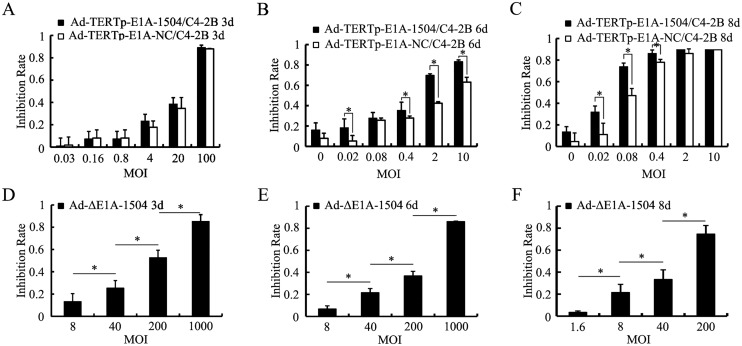
Inhibition effects of Ad-TERTp-E1A-1504 on C4-2B cells.Inhibition of proliferation of C4-2B cells was measured with MTT. A, B and C: inhibition resulting from Ad-TERTp-E1A-1504, Ad-TERTp-E1A-NC at different MOIs 3, 6, and 8 days after infection. They showed that the longer infection duration, the lower MOIs were needed to attain high inhibition rate, and MOIs of Ad-TERTp-E1A-1504 was lower than that of Ad-TERTp-E1A-NC. For example, to attain inhibition rate of 60% MOIs for Ad-TERTp-E1A-1504 and NC were 100 and 100(3 days), 2 and 10(6 days), 0.08 and 0.4(8 days) respectively. D, E, F: inhibition from Ad-ΔE1A-1504 at different MOIs at 3, 6, and 8 days after infection. Increasing infection duration and greater MOI did not inhibit proliferation as impressively as Ad-TERTp-E1A-1504 and Ad-TERTp-E1A-NC. *, P<0.05.